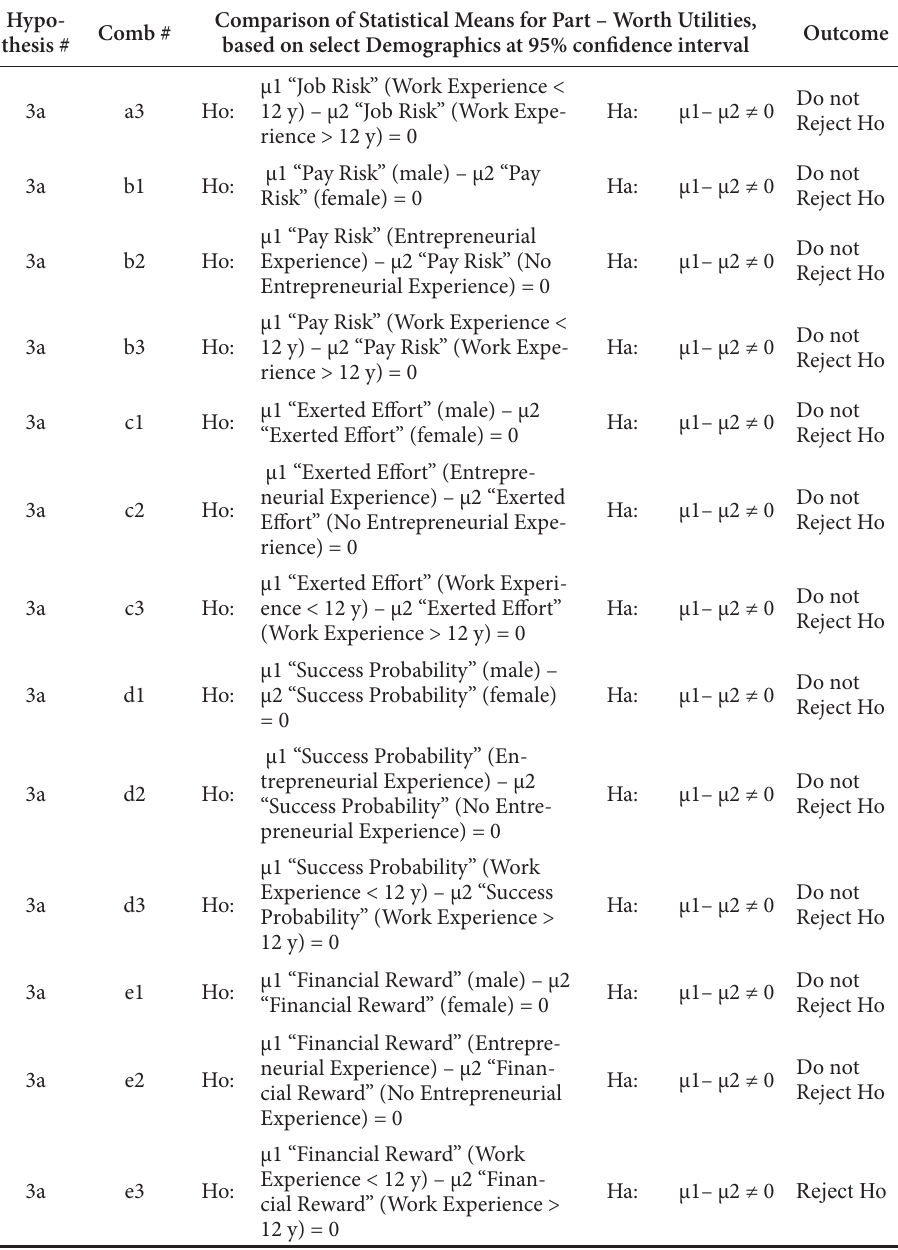
Comparison of Statistical Means for Part – Worth Utilities, based on select Demographics at 95% confidence